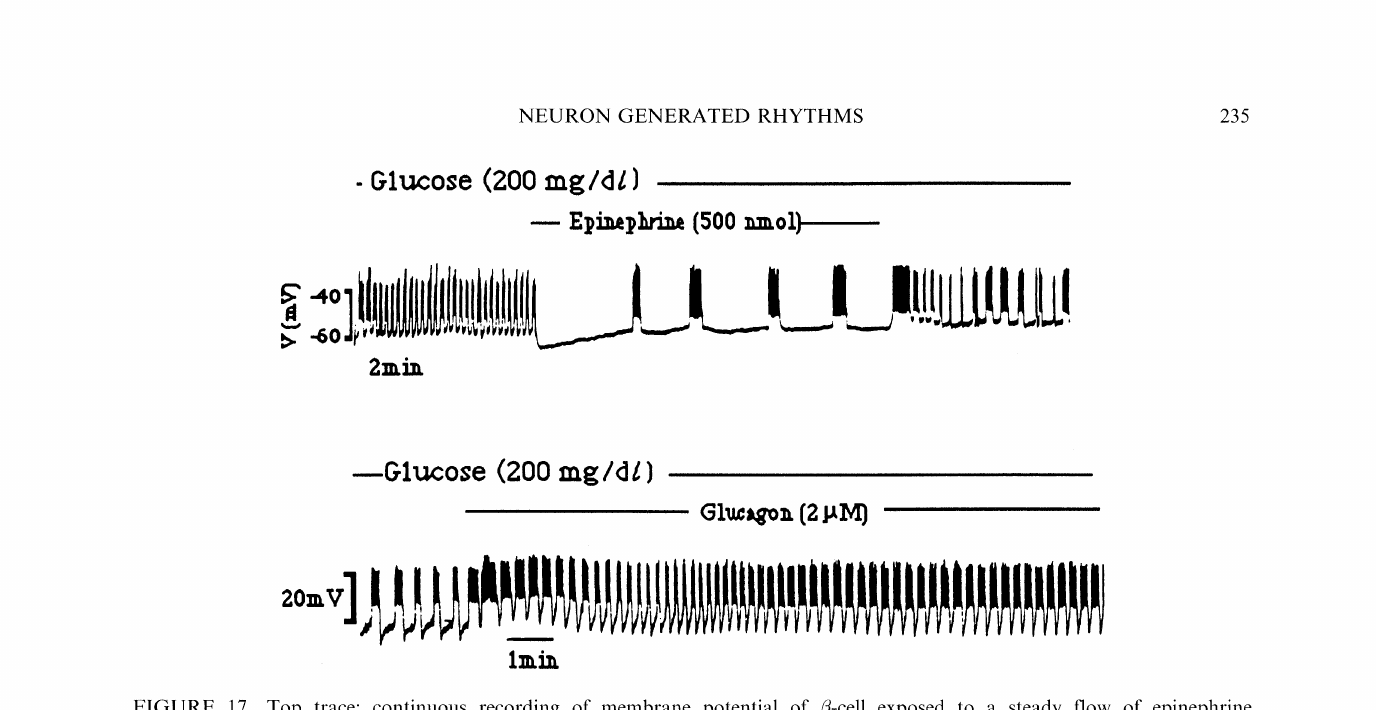
FIGURE 17 Top trace: continuous recording of membrane potential of /?-cell exposed to a steady flow of epinephrine (500nmol) for 15 min. Bottom trace: effect of glucagon (2 raM) on glucose induced electrical activity.